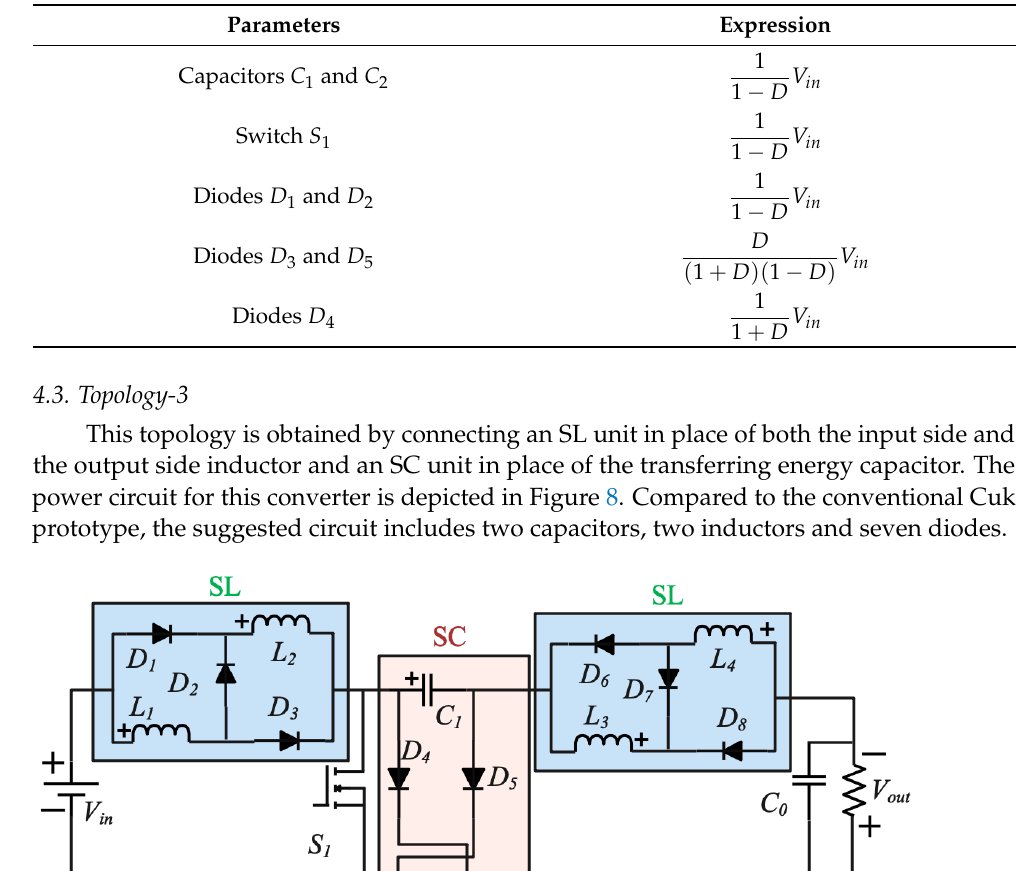
Table 2. Equations of voltages for type-2 SLSC CUK converter.